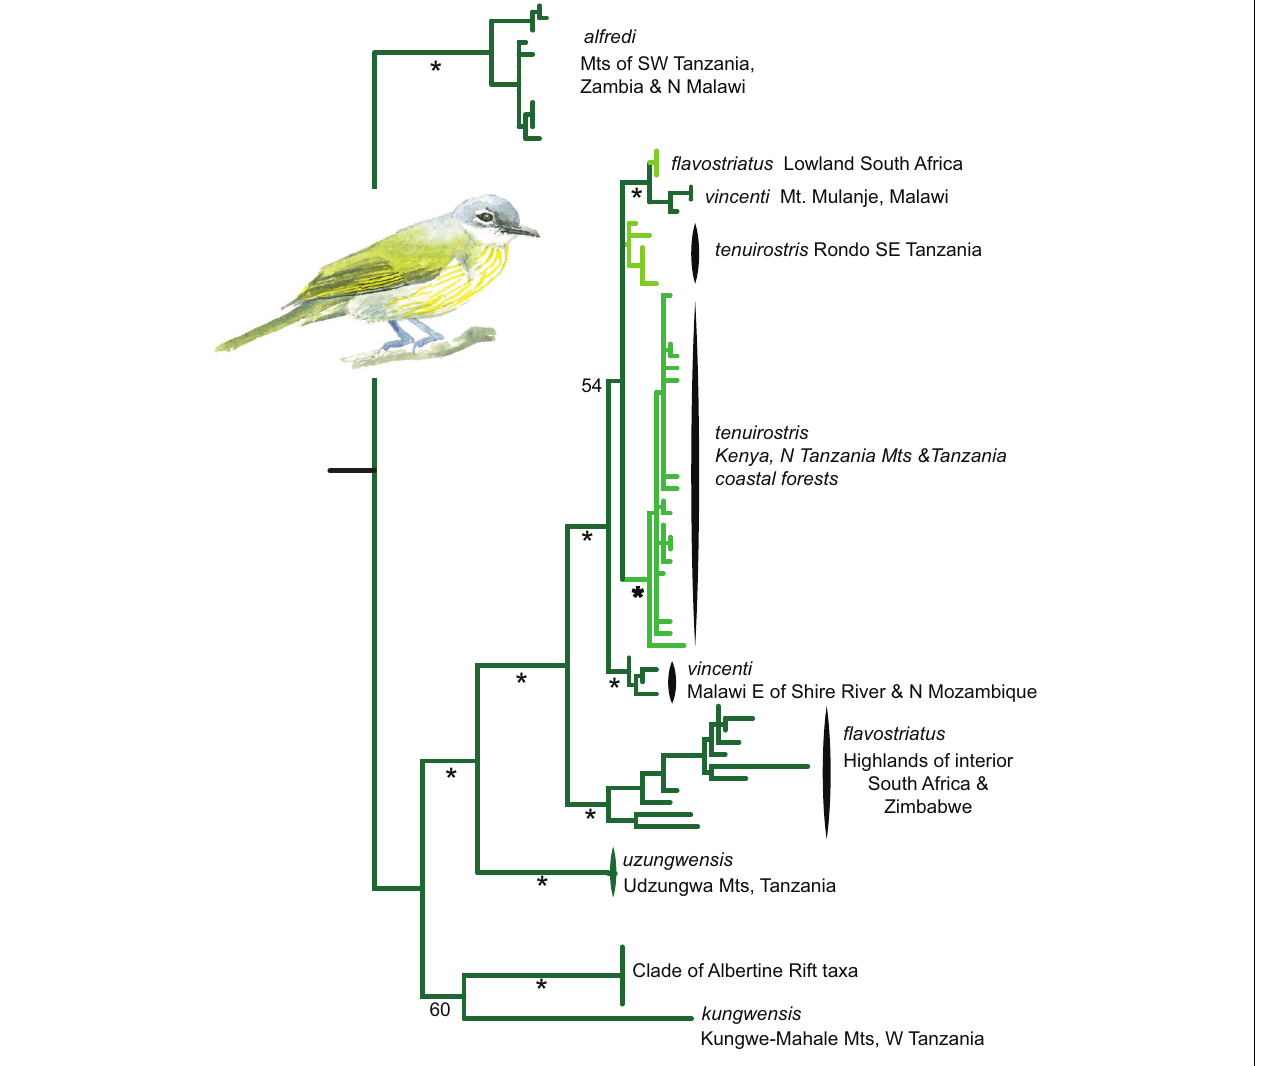
FIGURE 6 | Mitochondrial DNA (ND2) phylogeny of Yellow-streaked Greenbul Phyllastrephus flavostriatus populations across east and southern Africa derived from a partitioned maximum likelihood analysis. Dark green branches are indicative of lineages that occupy montane forest, light green is indicative of lowland forest, and the intermediate green color is indicative of lineages that occupy a broad elevation range extending into both lowland and montane forest. * > 75% bootstrap